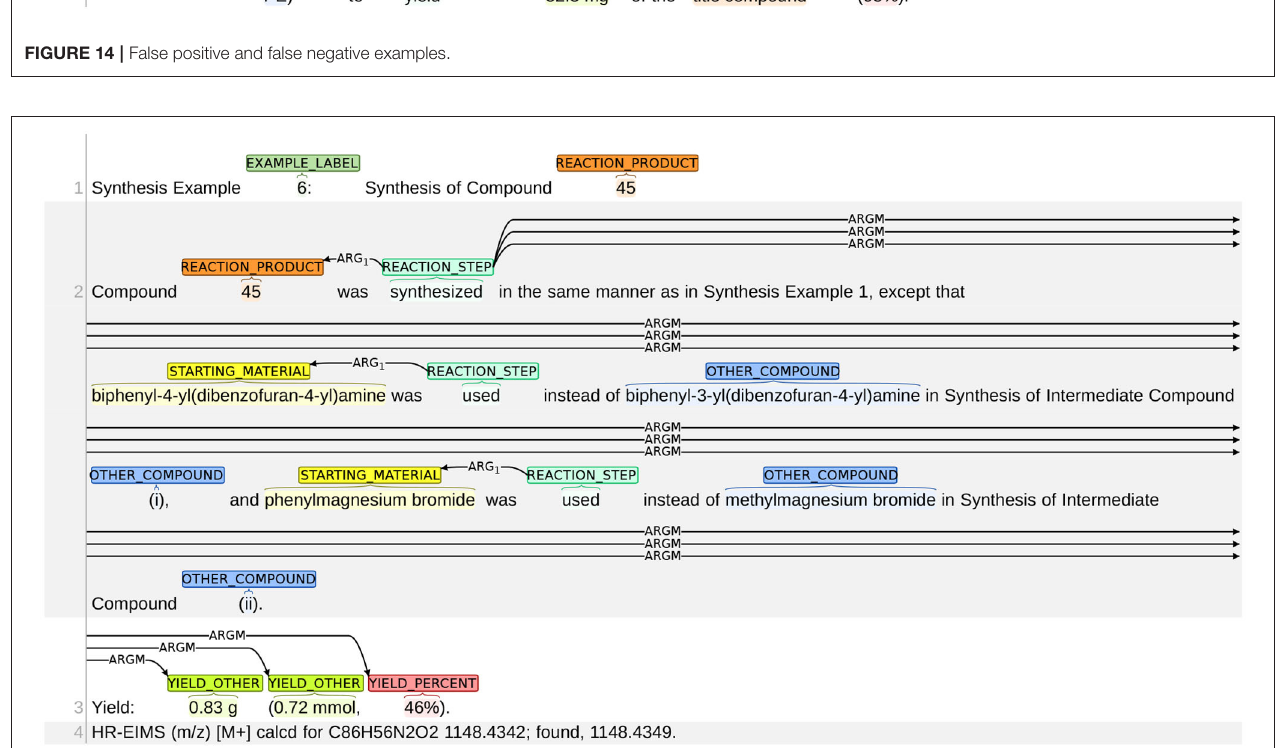
FIGURE 15 | An example of errors in relation prediction. Only the ground-truth labels are included in the figure. In terms of relation prediction, the top ranking system misses three relations: (1) synthesized → 0.83 g; (2) synthesized → 0.72 mmol; (3) synthesized → 46%.